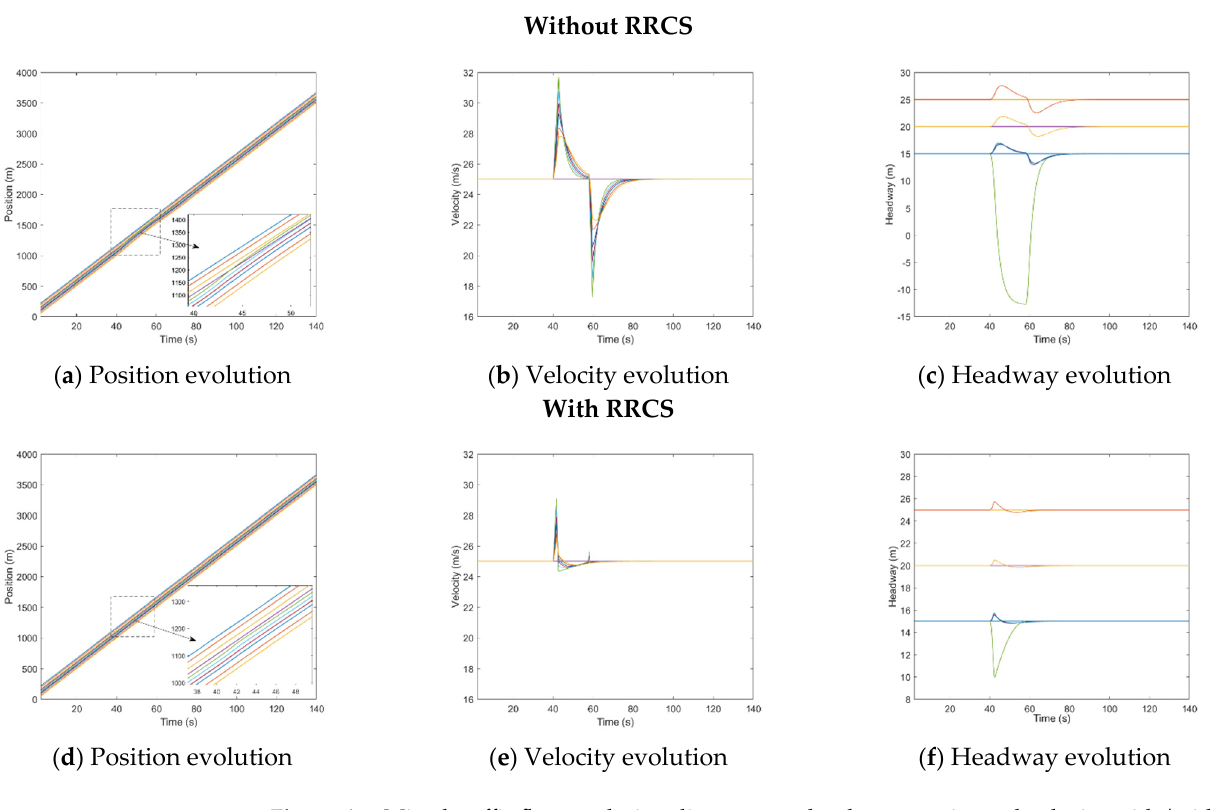
Figure A1. Mixed traffic flow evolution diagrams under the overestimated velocity with/without RRCS in PATH’s CACC car − following models.